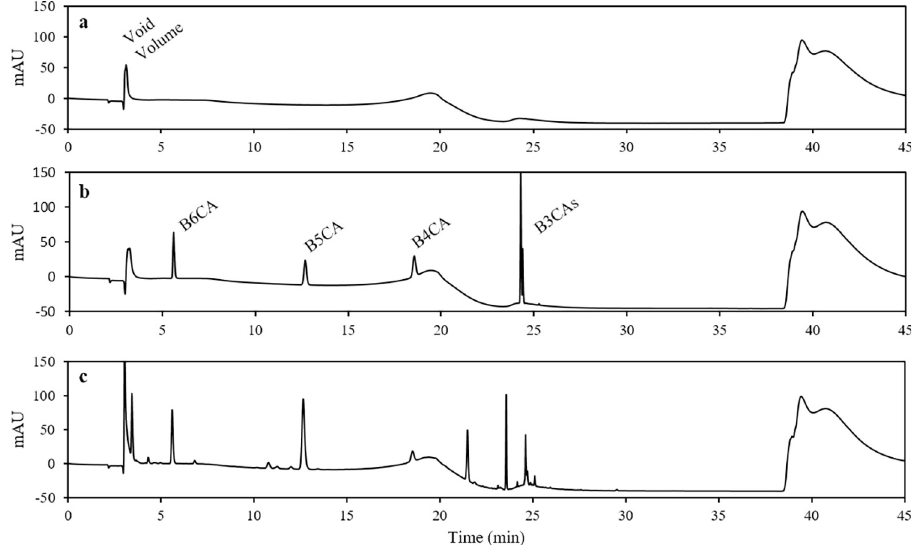
Fig 2. HPLC chromatograms of (a) mobile phase gradient as well as benzenepolycarboxylic acid separation in (b) a standard mixture and (c) a dissolved organic matter sample from a fire-affected headwater stream. As seen in each chromatogram, the initial peak is representative of void volume and the baseline variation is due to changes in mobile phase gradient. The BPCA standard peaks in b are indicative of B6CA, B5CA, a B4CA (1,2,4,5-B4CA), and three B3CAs (1,2,4-B3CA, 1,2,3-B3CA, 1,3,5-B3CA). B3CAs and B4CA are not quantified as part of this method but are included in chromatographic analyses to confirm complete elution of sample.